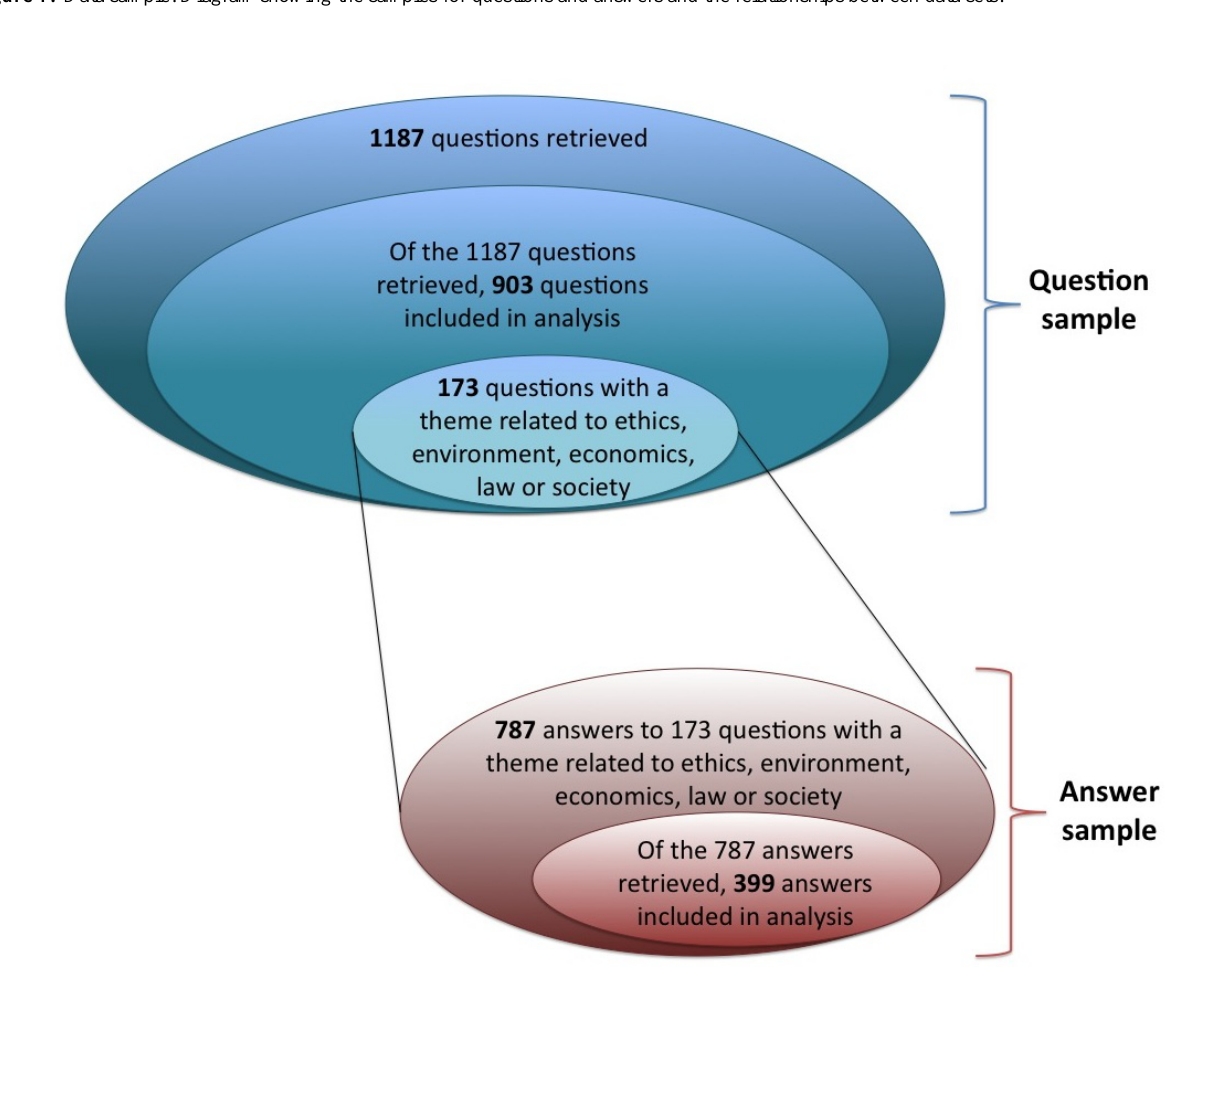
Figure 1. Data sample. Diagram showing the samples for questions and answers and the relationships between data